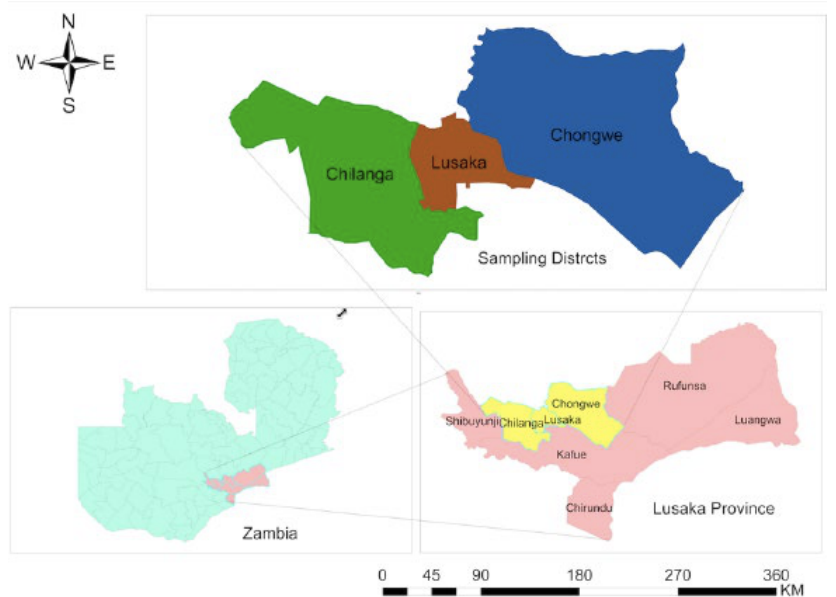
Figure 2. Map of the Study Sites Selected from Lusaka province in Zambia; Map was generated using the software ArcGIS version 10.3.